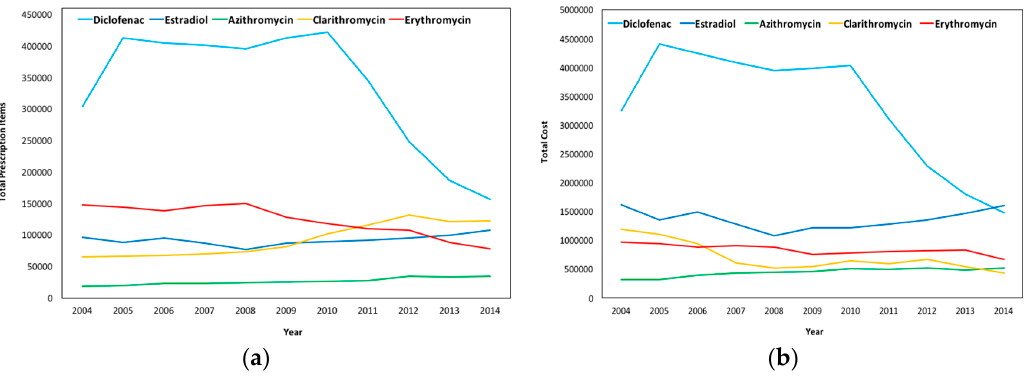
Figure 11. Northern Ireland’s Total ( a ) Prescription Items and ( b ) Cost (£) per substance from 2004 to 2014.